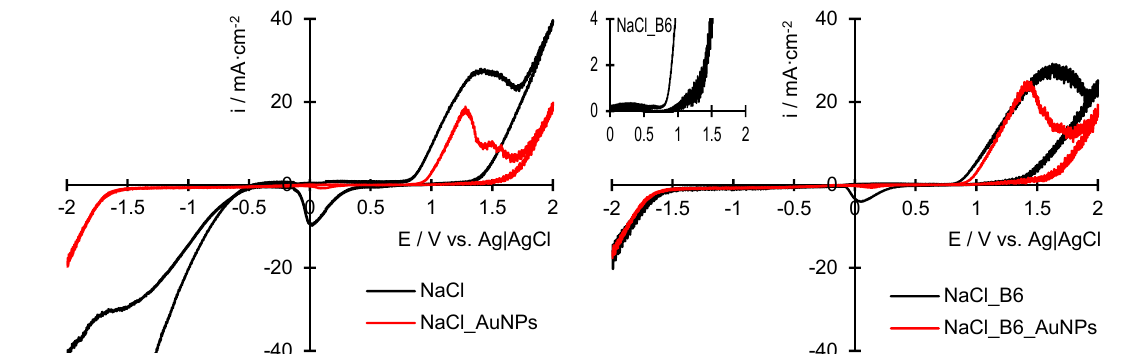
Figure 5. Cyclic voltammetry responses of gold electrode in 0.1 mol × L − 1 NaCl support electrolyte in the absence and in the presence of 75 mg × L − 1 gold nanoparticles (AuNPs) and 2.9 × 10 − 4 mol × L − 1 pyridoxine (vitamin B 6 ).